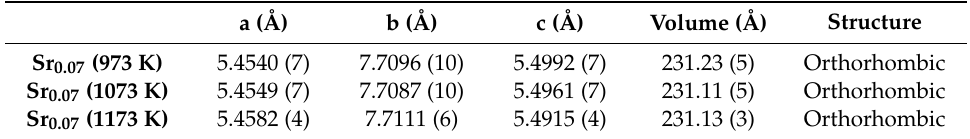
Figure 1. Rietveld refinements for La 0.7 Ca 0.23 Sr 0.07 MnO 3 nanofibers heat treated at ( a ) 973 K, ( b ) 1073 K and ( c ) 1173 K correspond to single-phase orthorhombic structure (Pnma) with crystallite size of ( a ) 48 nm, ( b ) 50 nm and ( c ) 62 nm, respectively. Table 1. Summary of lattice parameters, cell volume and crystal structure obtained from Rietveld